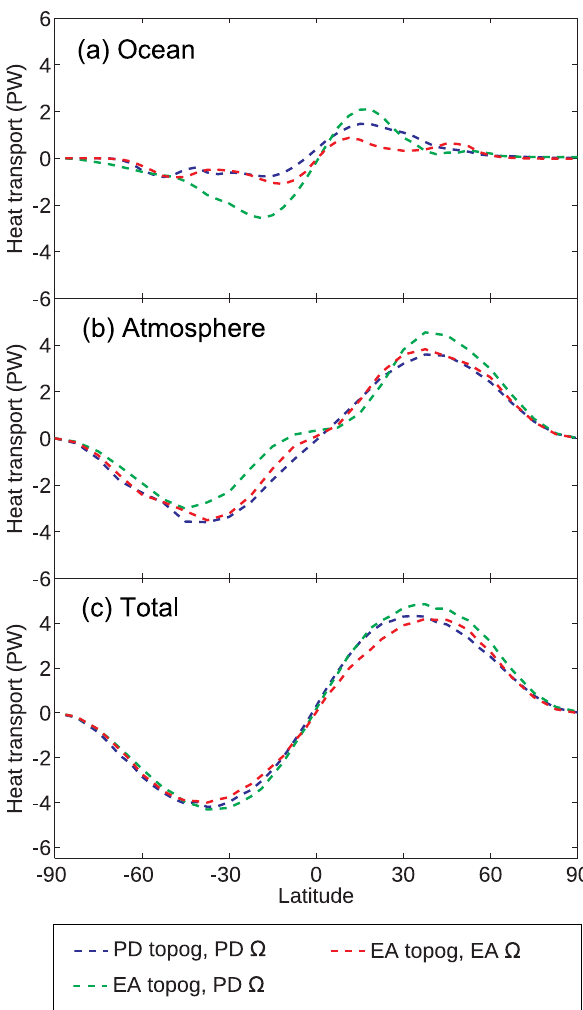
Fig. 17: [new figure] (a) Oceanic, (b) atmospheric and (c) total meridional heat transport for three Fig. 17. (a) Oceanic, (b) atmospheric and (c) total meridional states with early Archean solar constant ( SOL = 0 : 75 ) and global mean SAT near the present-day heat transport for three states with early Archean solar constant (SOL=0.75) and global mean SAT near the present-day value: value: present-day topography and rotation rate (blue, pCO 2 =0.48 bar), early Archean topography present-day topography and rotation rate (blue, p CO 2 =0.48bar), and present-day rotation rate (green, pCO 2 =0.40 bar), early Archean topography and rotation rate early Archean topography and present-day rotation rate (green, p CO 2 =0.40bar), early Archean topography and rotation rate (red, (red, pCO 2 =0.60 bar). p CO 2 =0.60bar).